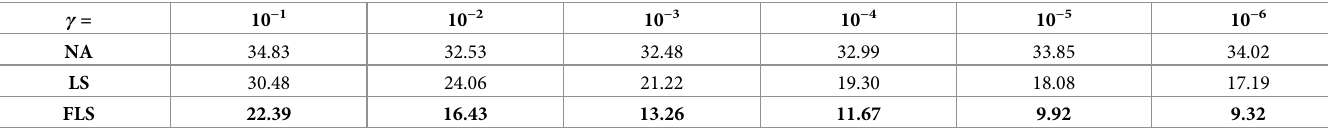
Average running times (in Seconds, Preprocessing excluded) of different algorithms for DNA pattern ( m = 21) from JASPAR and varying p-Values, and each reported time is an average of 10